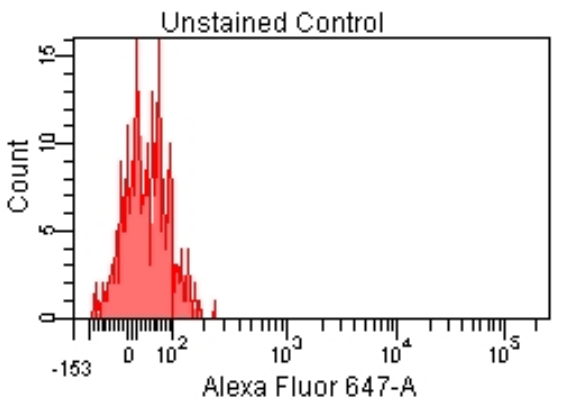
Figure 2. Unlabeled cell suspension (no specific fluorescence signals)—blue laser stimulation.